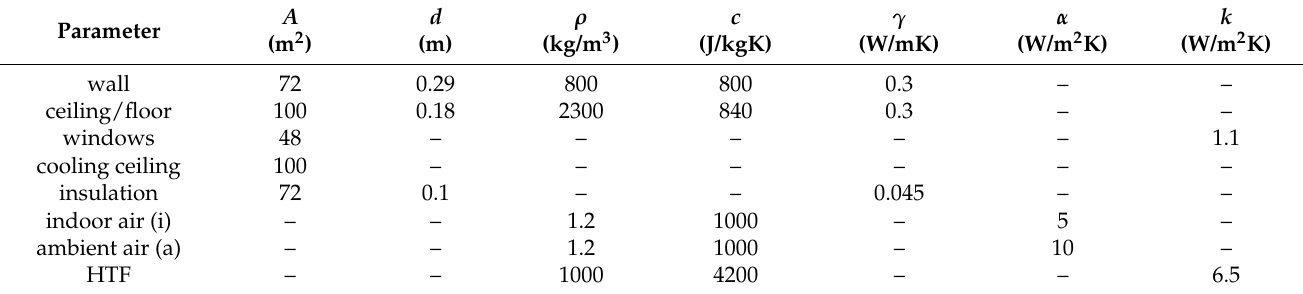
Figure 7. The schematic view of model office building: 1 —outer wall, 2 —ceiling/floor, 3 —insulation, 4 —window, 5 — cooling ceiling, 6 —capillary tube mats. Table 2. Detailed information about the elements included in the office